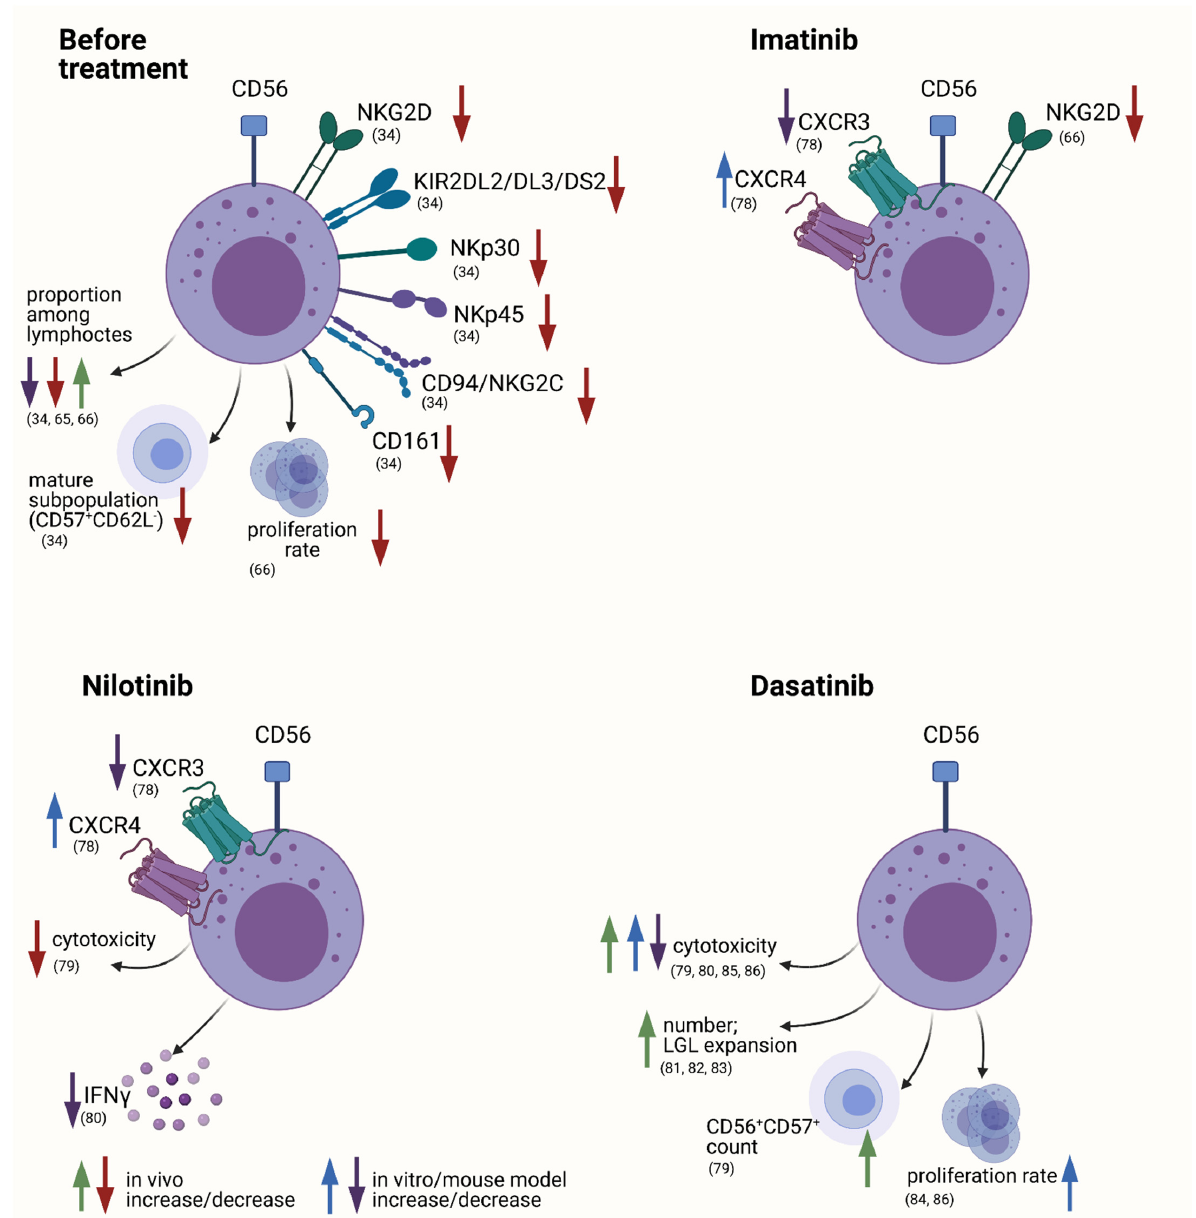
Figure 1. Phenotypic and functional alterations in the NK cell compartment of CML patients before therapy initiation, as well as TKI-specific changes. An in vivo increase or decrease is displayed with green or red arrows respectively, while blue and purple arrows indicate an observed increase or decrease in vitro or using a mouse model. References are given in brackets. Created with BioRender.com (accessed on August 27 th 2021).